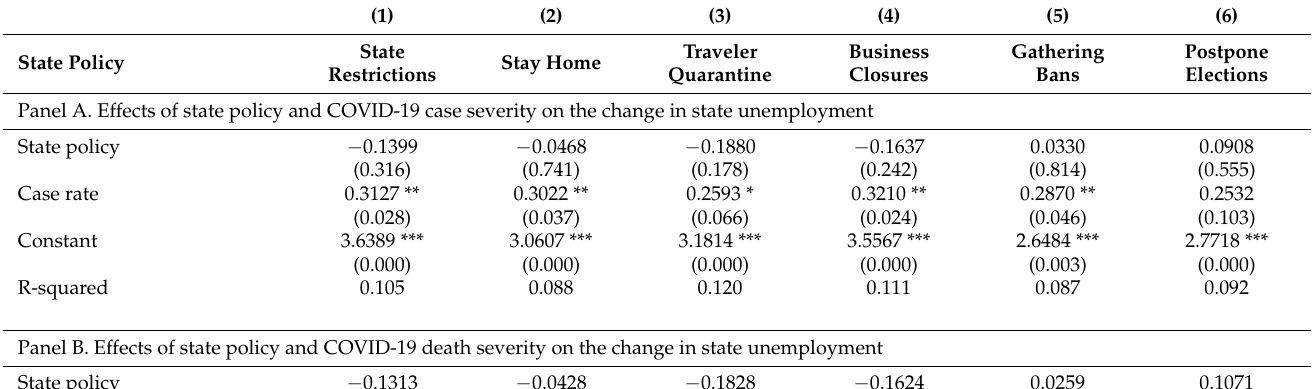
Table 10. Effects of state policies and COVID-19 severity on local unemployment and bankruptcy